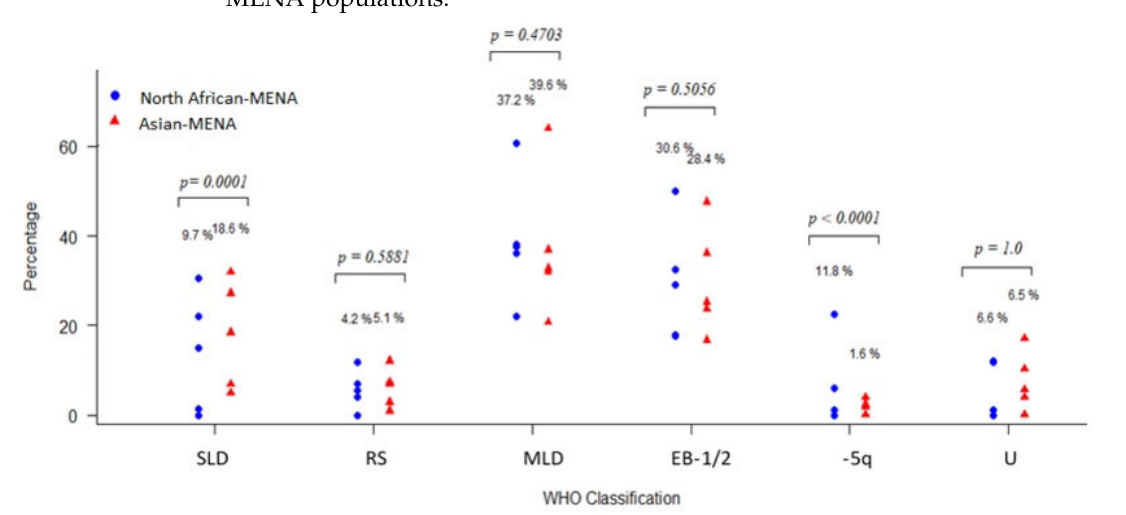
Figure 4. Comparison of MDS subtypes in the Asian MENA and North African MENA populations. MDS = myelodysplastic syndrome, MLD = multilineage dysplasia, SLD = single-lineage dysplasia, RS = ring sideroblasts, EB = excess blasts, Del5q = isolated del(5q), MDS-U = unclassifiable.